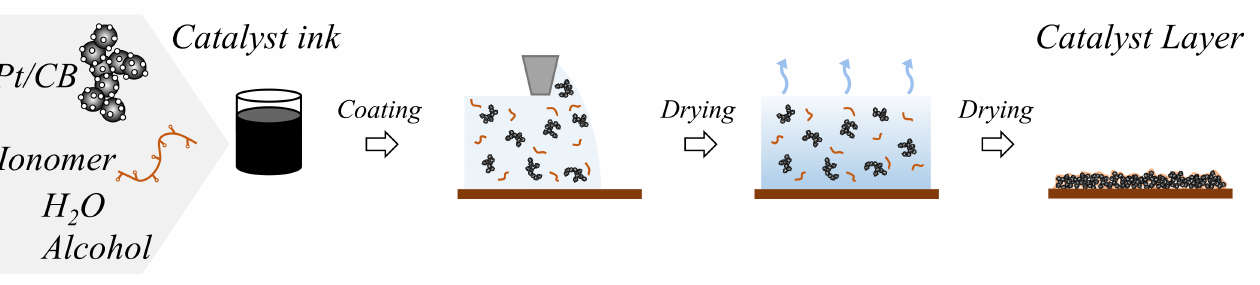
Figure 1. Fabrication of the catalyst layer from catalyst